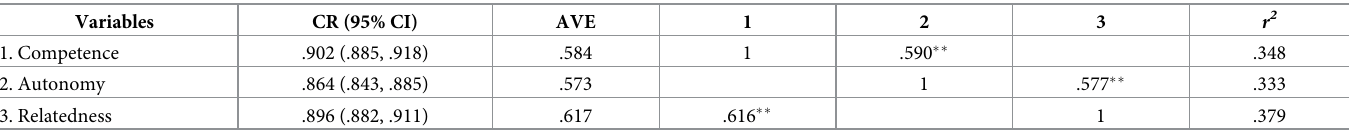
Table 2. Composite reliability (CR), average variance extraction (AVE), factor correlation and squared correlation for PNSE-M final model. Variables